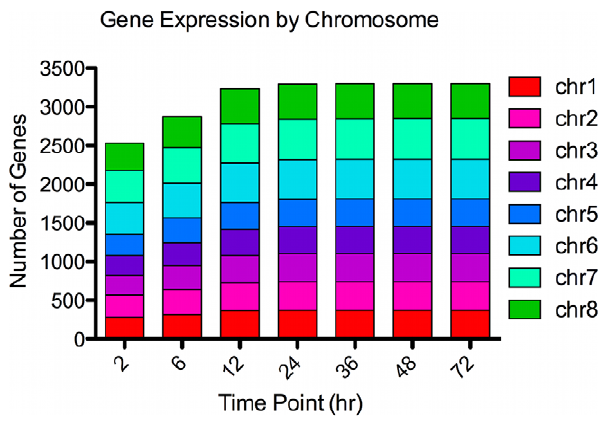
Figure 2. Expression by Chromosome. For each time point, the number of genes with detectable expression (non-zero) was quantified by chromosomal location.